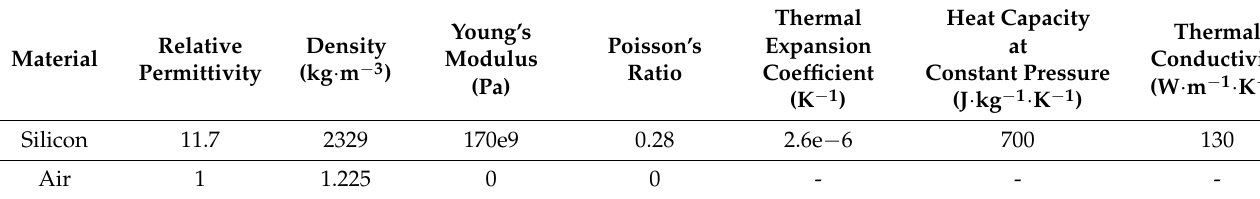
Mass change versus frequency shift is shown in Figure 6 for a microcantilever mass sensor, which includes a flexible beam that is made of silicon with a length, width, and